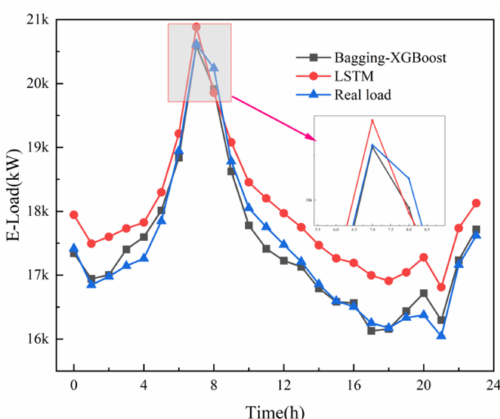
Figure 11. Electric load forecast results. Electrical load forecasting results compared with